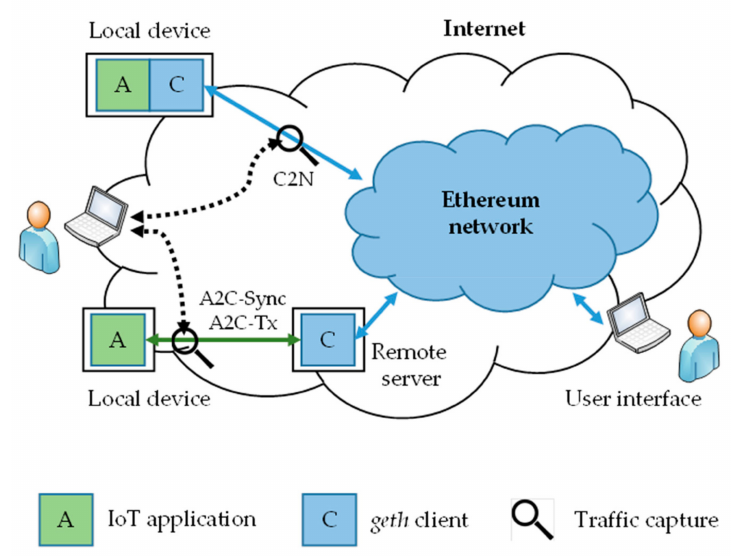
Figure 6. Pilot setup for tra ffi c measurements